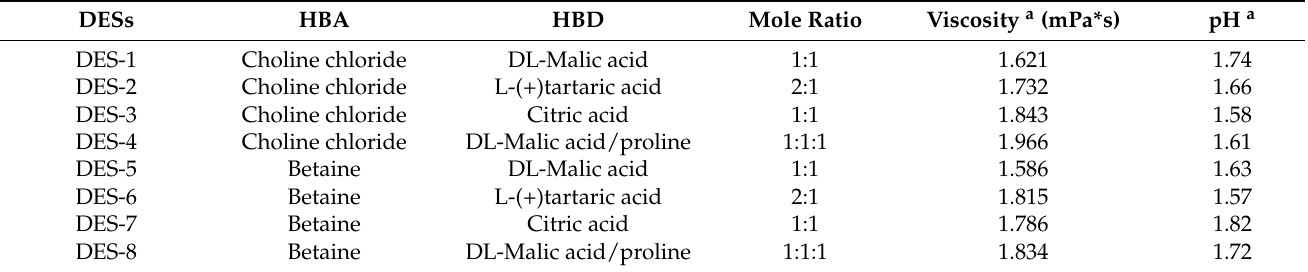
Table 1. Components of DESs and physicochemical properties of their aqueous